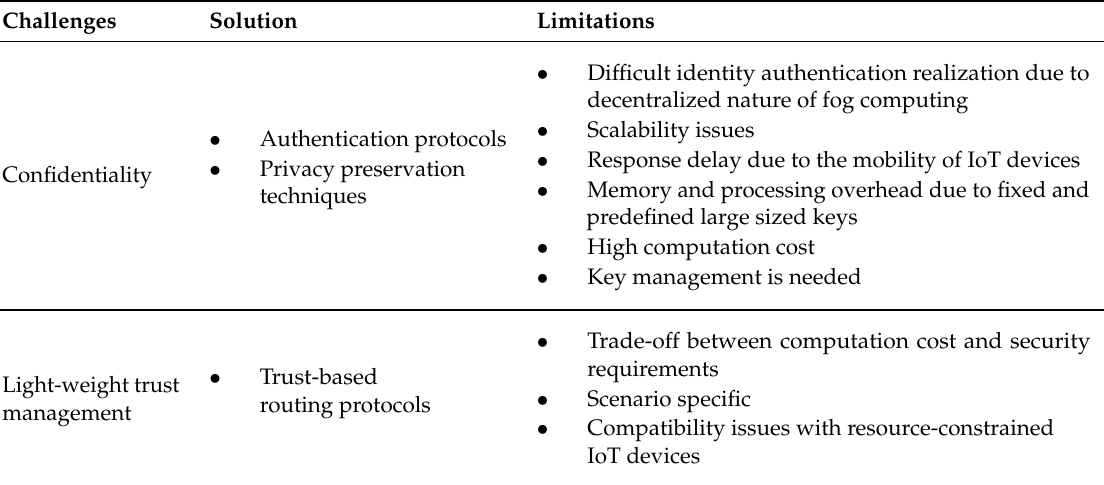
Table 5. Device level security challenges and solutions with respective